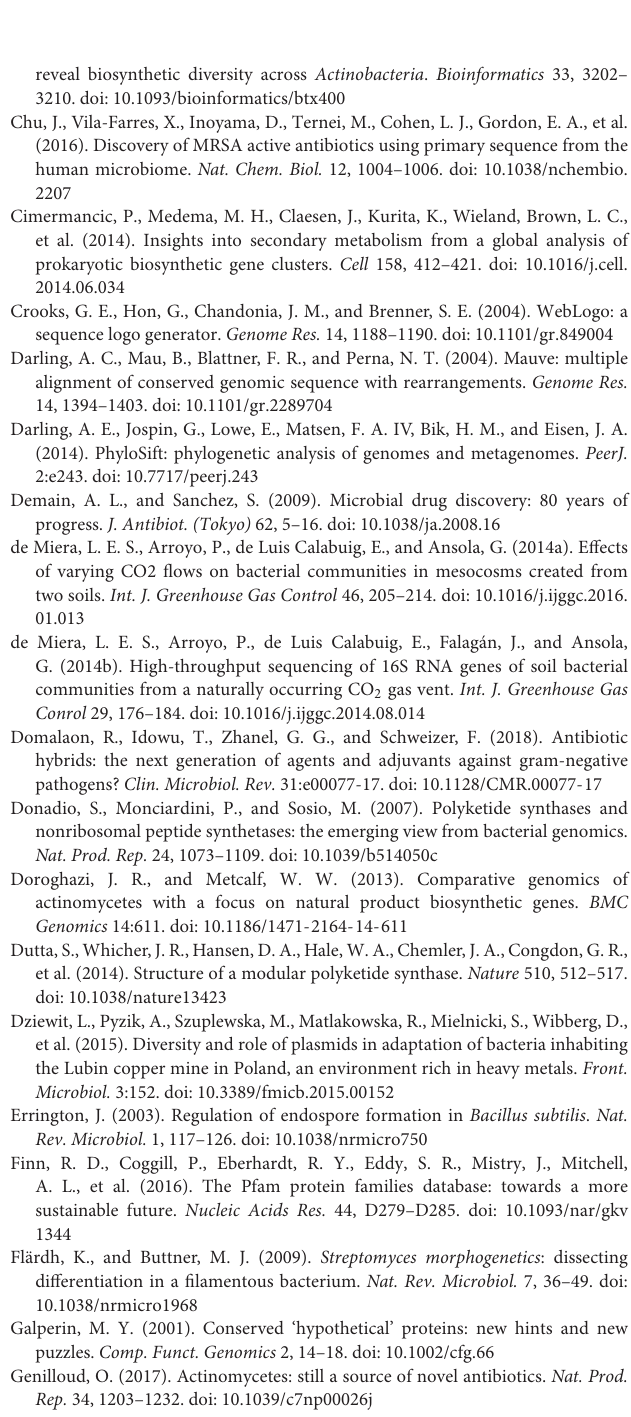
TABLE S6 | List of the putative BGCs identified by ClusterFinder (A) and antiSMASH (B) in nine Ktedonobacteria strains and their similarities to known clusters. TABLE S7 | Domain composition and organization of the putative NRPS clusters (A) , T1PKS clusters (B) , T2PKS clusters (C) , and NRPS-TIPKS clusters (D) identified in nine Ktedonobacteria strains, and AMP-binding domain amino acid substrate specificities in the NRPS-TIPKS clusters (E)